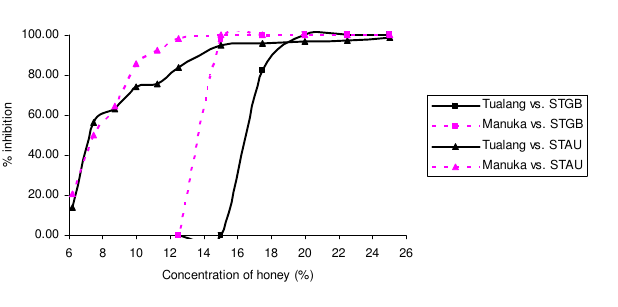
Tualang vs. STGB Manuka vs. STGB Tualang vs. STAU Manuka vs. STAU